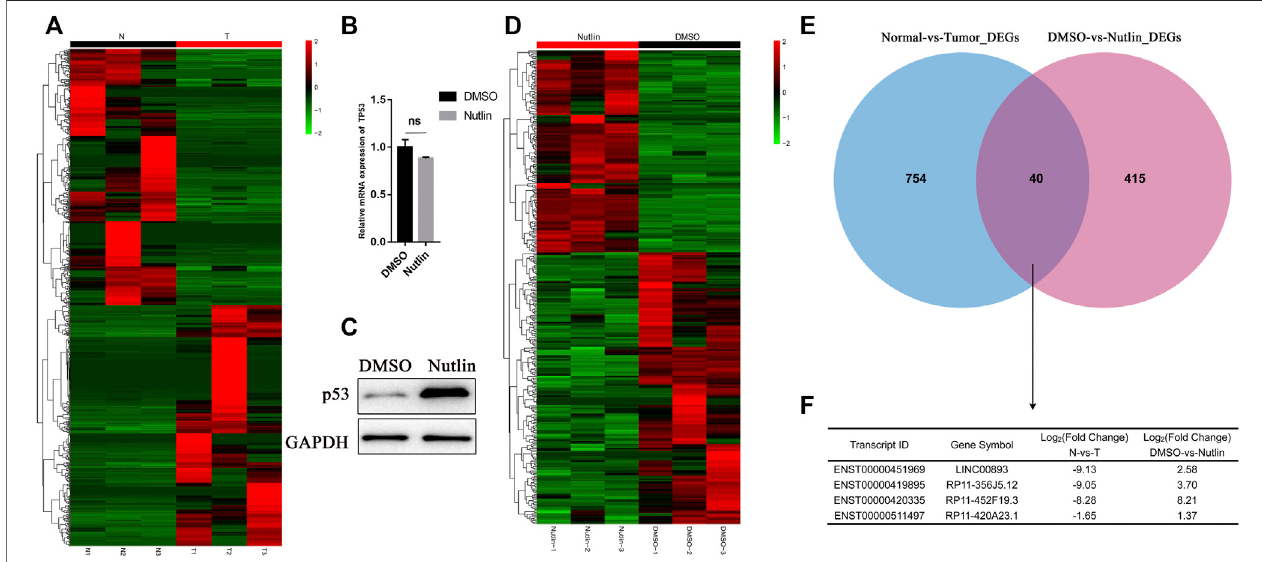
FIGURE1| Identi fi cationofp53-regulatedtumorsuppressorlncRNAsingastriccancer (A) HeatmapisshownforthedifferentiallyexpressedlncRNAsidenti fi edby RNAsequencingbetweenthreegastriccancertissuesandpairednormaltissues (B , C) Isogenic TP53 -WTAGScellswereuntreatedortreatedwithNutlin-3for12 h,RT- qPCR and immunoblotting was performed for p53 and the loading control GAPDH (D) Heat map is shown for the differentially expressed lncRNAs identi fi ed by RNA sequencing in duplicate from AGS cells untreated or treated with nutlin-3 for 12 h. Upregulated genes are shown in red and downregulated genes in green (E , F) Venn diagram showing the overlap between the transcriptomes downregulated in gastric cancer tissues and the transcriptomes upregulated after nutlin-3 treatment of AGS cells.